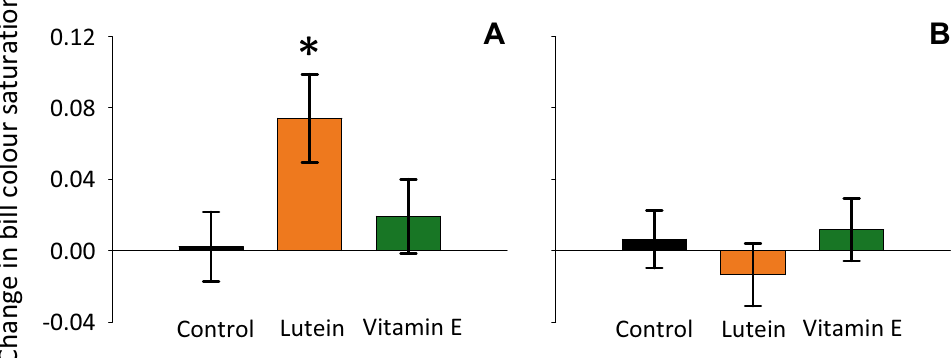
Figure 1. Changes in ( A ) female and ( B ) male bill colour saturation (mean ± SE) from before to after each diet manipulation (control in black, lutein-supplemented in orange, and vitamin E-supplemented in green). Asterisks mark statistically significant differences in post-hoc tests against the control treatment.